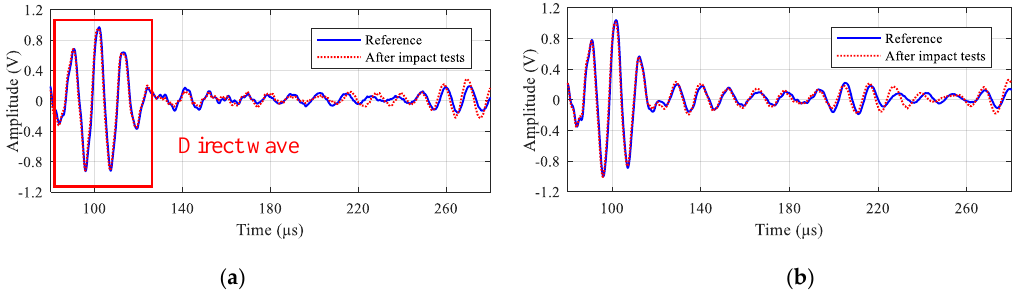
Figure 15. GW signals of different paths before and after impact tests. ( a ) Path 1-2. ( b ) Path 2-3.